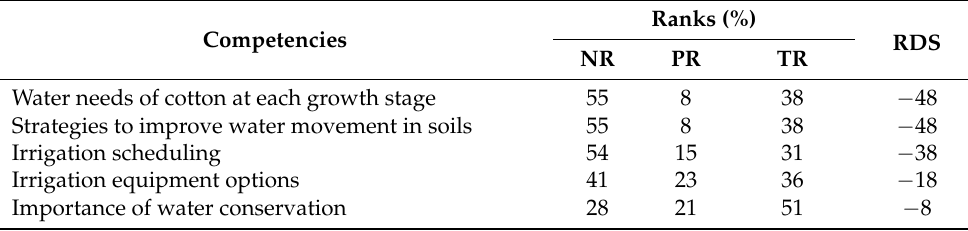
Table 3. Ranked Discrepancy Scores for individual competencies in water management. Competencies